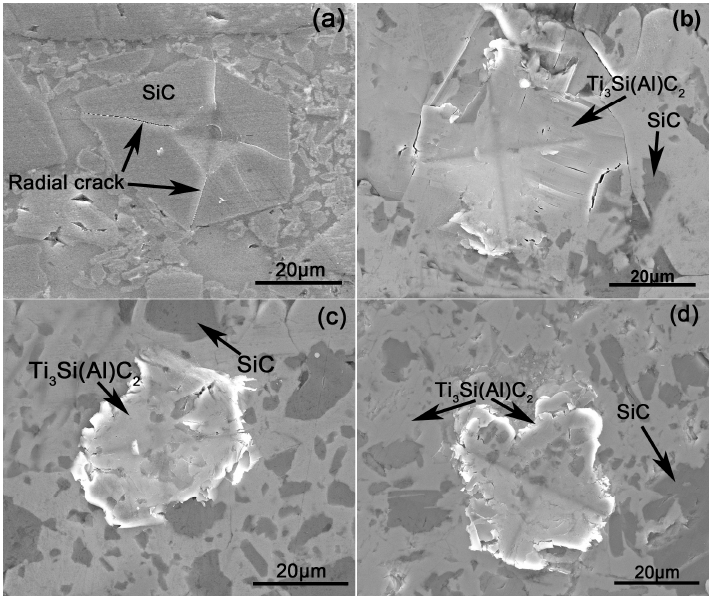
Figure 7. Indentation micrographs of the polished surfaces of the composites infiltrated by the Al–Si–xTi alloy (Si: 10 wt.%) with Ti contents (wt.%) of ( a ) 0, ( b ) 5, ( c ) 10, and ( d ) 15.